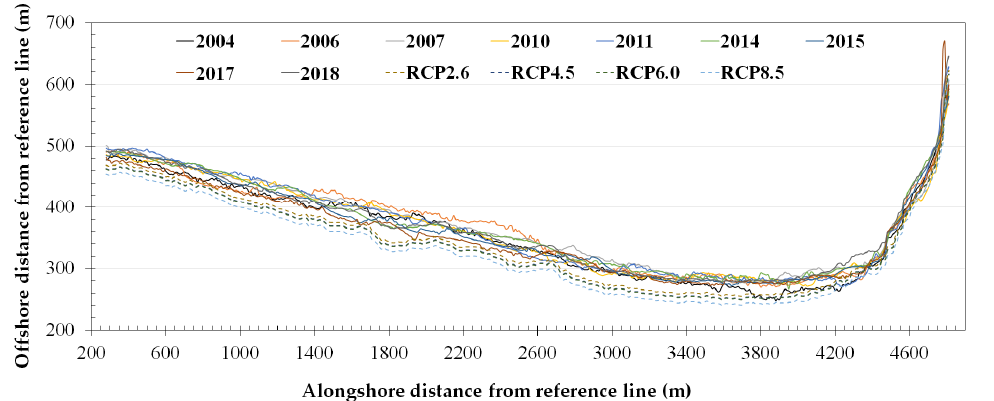
Figure 4. Chalatat beach.